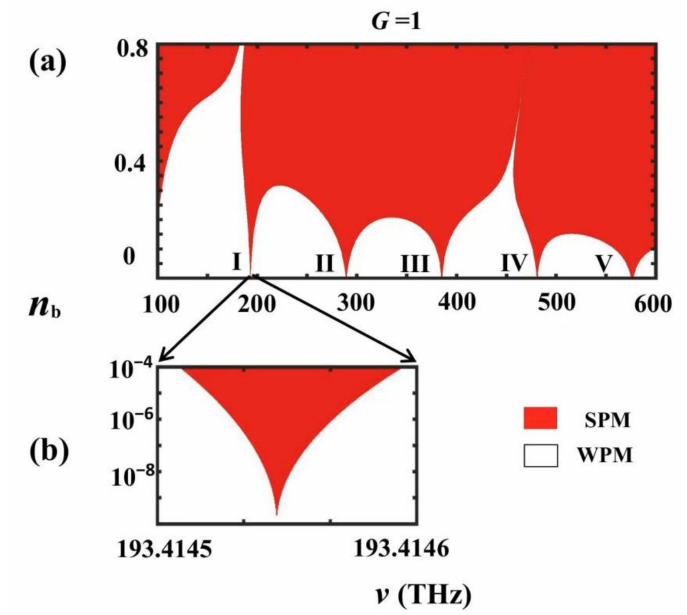
Figure 3. Photonic pattern distribution map of 1D PTSPOWN of G = 1, where the white and red areas represent weak modes (WPMs) and strong modes (SPMs), respectively: ( a ) a general map of the frequency (wavelength) range corresponding to the thick red line in Figure 2; ( b ) an enlarged view of the first extremum spontaneous PT-symmetric breaking point near the communication